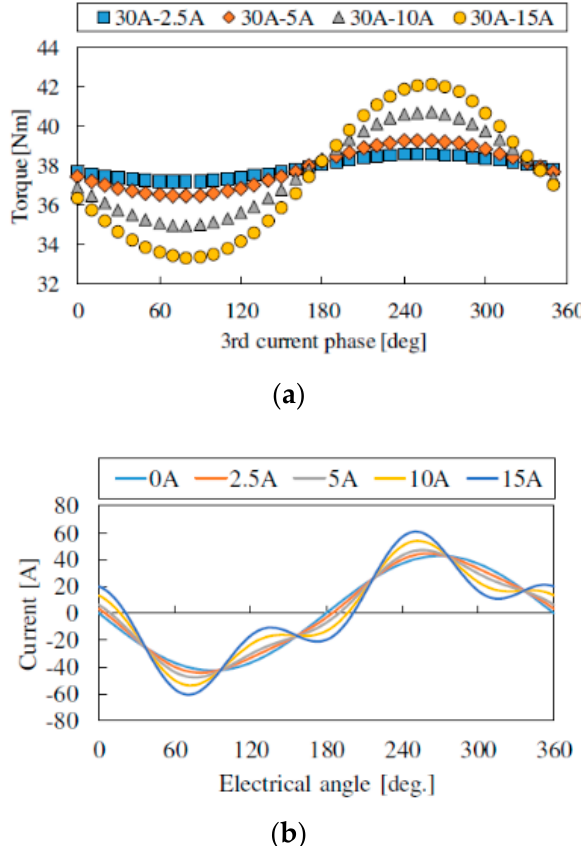
Figure 12. ( a ) Output torque amplitude with 3rd harmonics current. Fundamental current is 30 A,